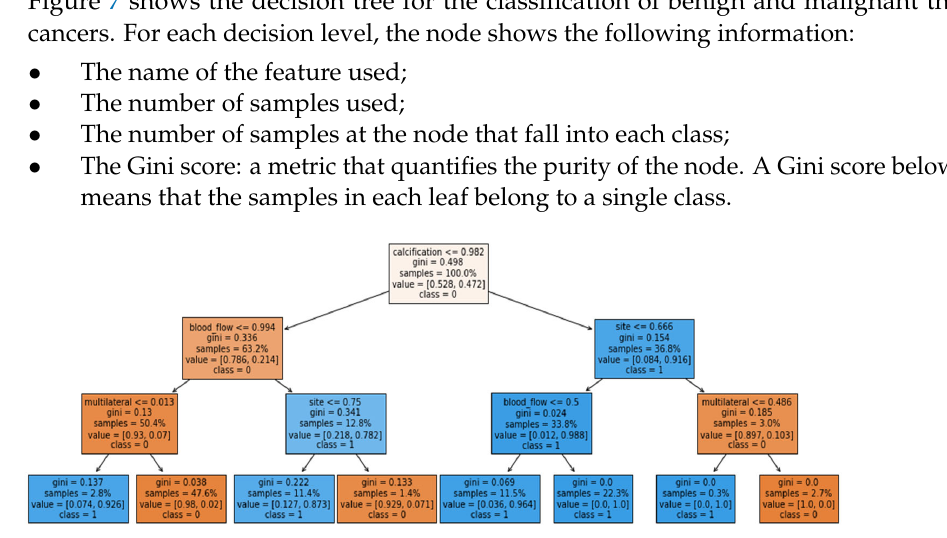
Figure 7. A decision tree representation of the ANN model. Here “class” represents the malignancy of the cancer, with a value of 0 for a benign cancer and 1 for a malignant cancer. “value” represents the fraction of samples that fall into each class.